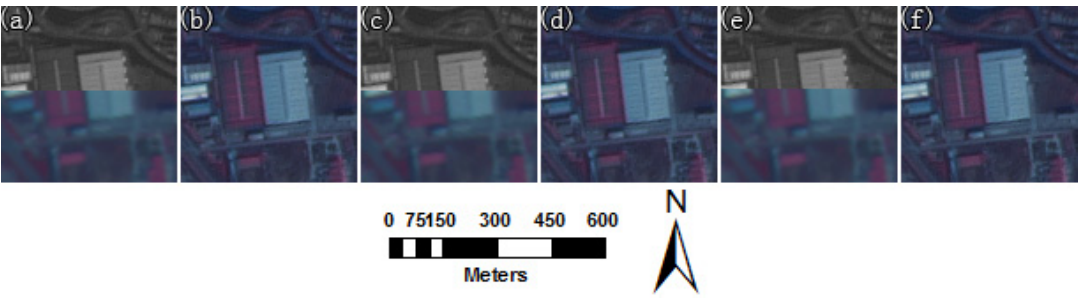
Figure 12. Registration and fusion results of Dataset 3 using methods of